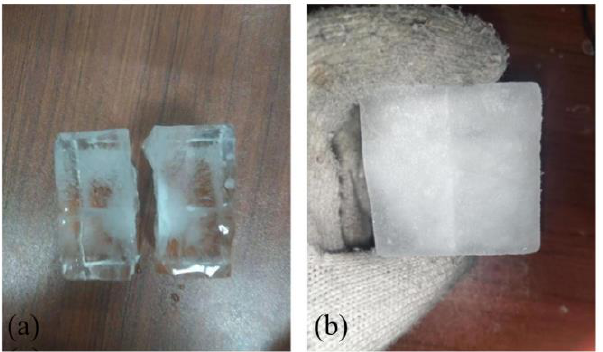
Figure 12. Split ice samples in shear strength test. ( a ) Ice sample of freshwater failure. ( b ) Ice sample of seawater failure.